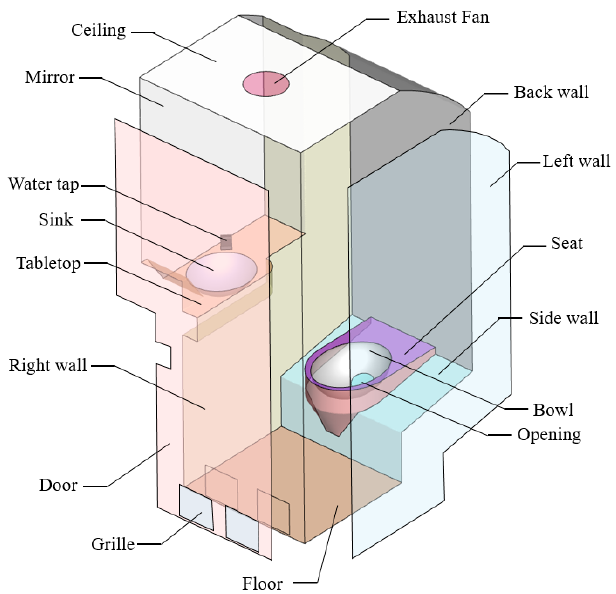
Figure 1. Schematic of the aircraft lavatory model.